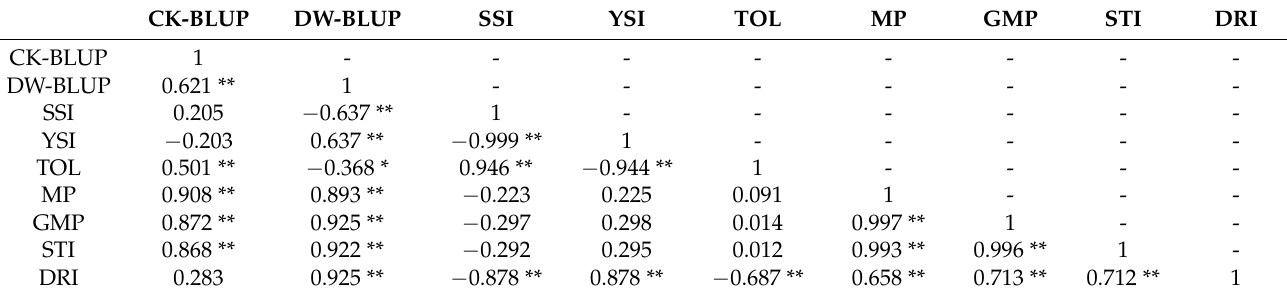
Table 4. Correlation analysis of yield best linear unbiased predictor (BLUP) values and seven drought tolerance indices.